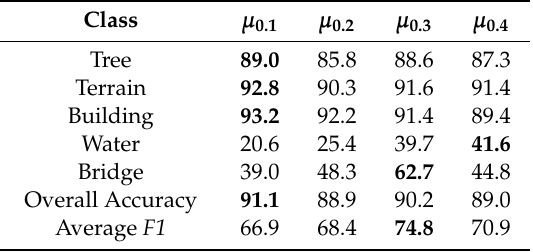
Figure 9. ( a ) Classification results without intensity; ( b ) Classification results with intensity. Building, navy blue; tree, red; water, brown; terrain, green; and bridge, cyan. Table 3. Results for the testing area after adding intensity values. The F1 score is used to evaluate the performance. Bold numbers show the highest values within di ff erent